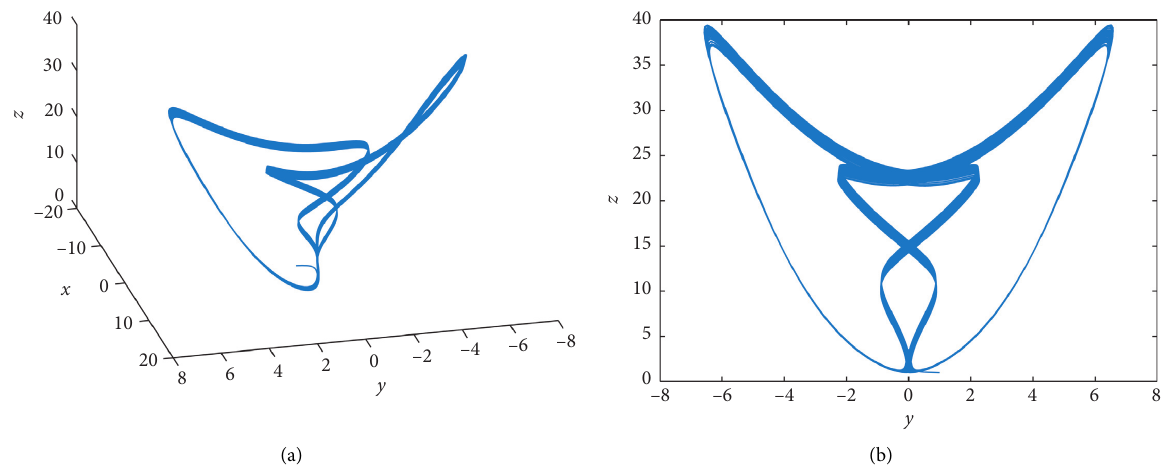
Figure 3: Phase portraits of the fractional system with α � 0 .